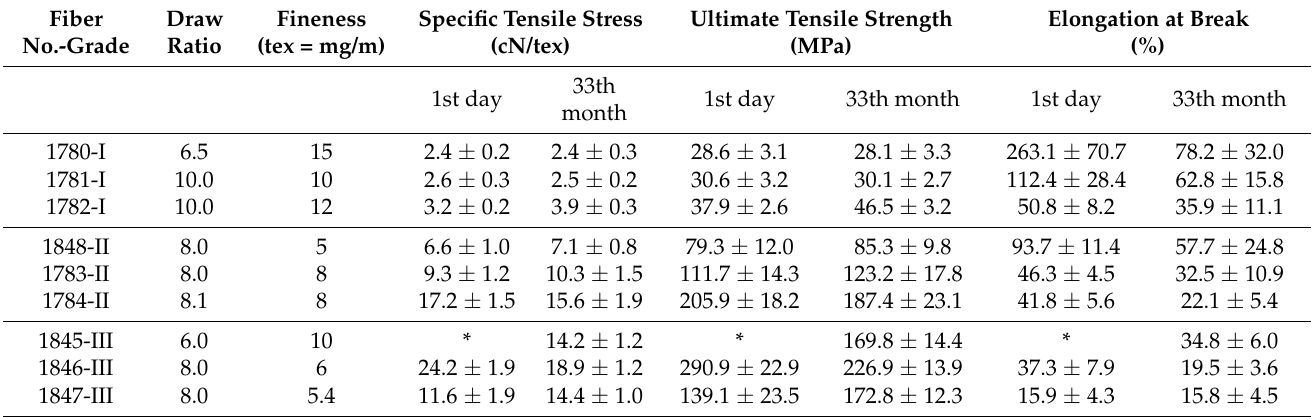
Table 6. Filament draw ratios, fineness and mechanical properties.